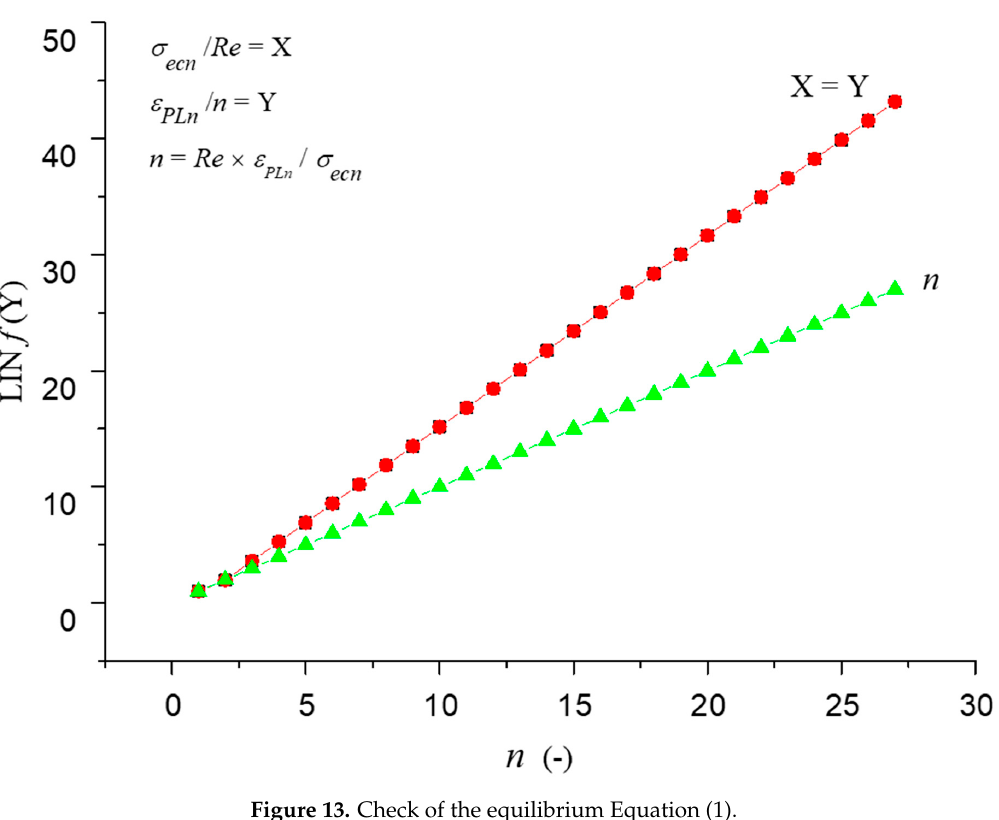
Figure 13. Check of the equilibrium Equation (1).